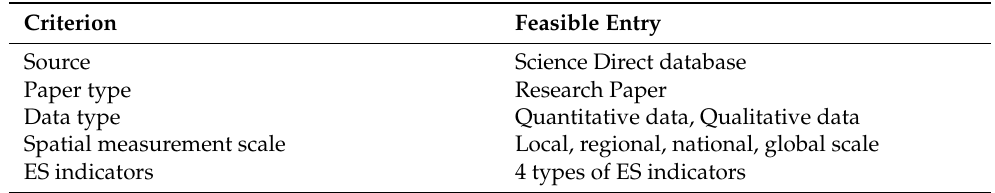
Table 1. Criteria of Review with Feasible